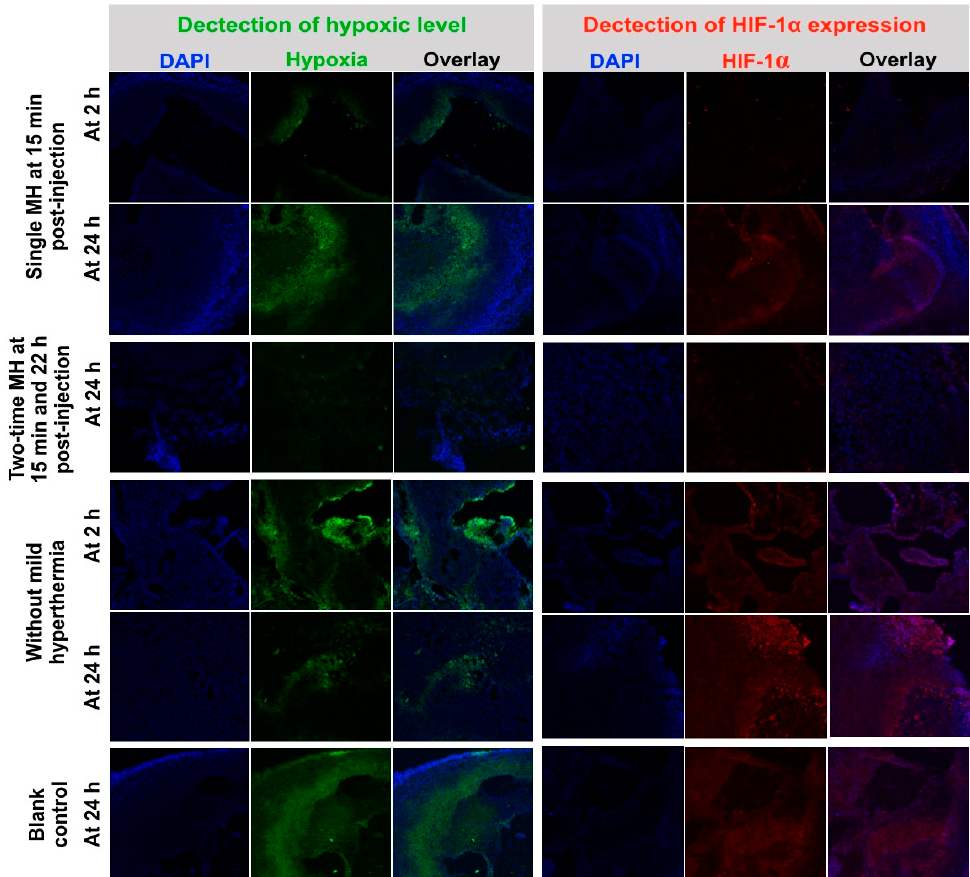
Figure 7. Alleviation mechanism of tumor hypoxia under mild hyperthermia (MH) stimulation. Representative immunofluorescence images of pimonidazole-stained hypoxic signals (green) in left column, and HIF-1 α antibody-stained hypoxic signals (red) in right column. Nuclei were stained with DAPI (blue).